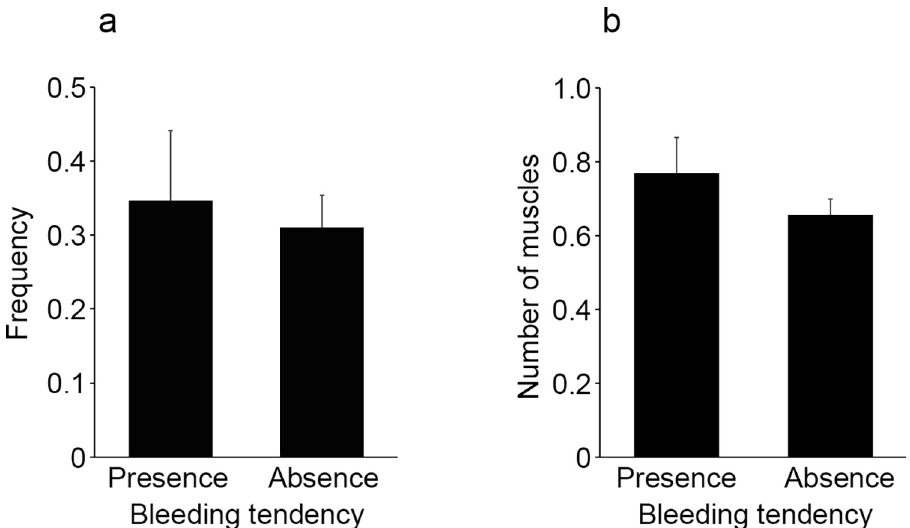
Fig 7. Comparison of the frequency of intramuscular hemorrhage (a) and the number of muscles with hemorrhage (b) between victims with or without a potential bleeding tendency. All values represent the mean ± SEM. � p < 0.05.